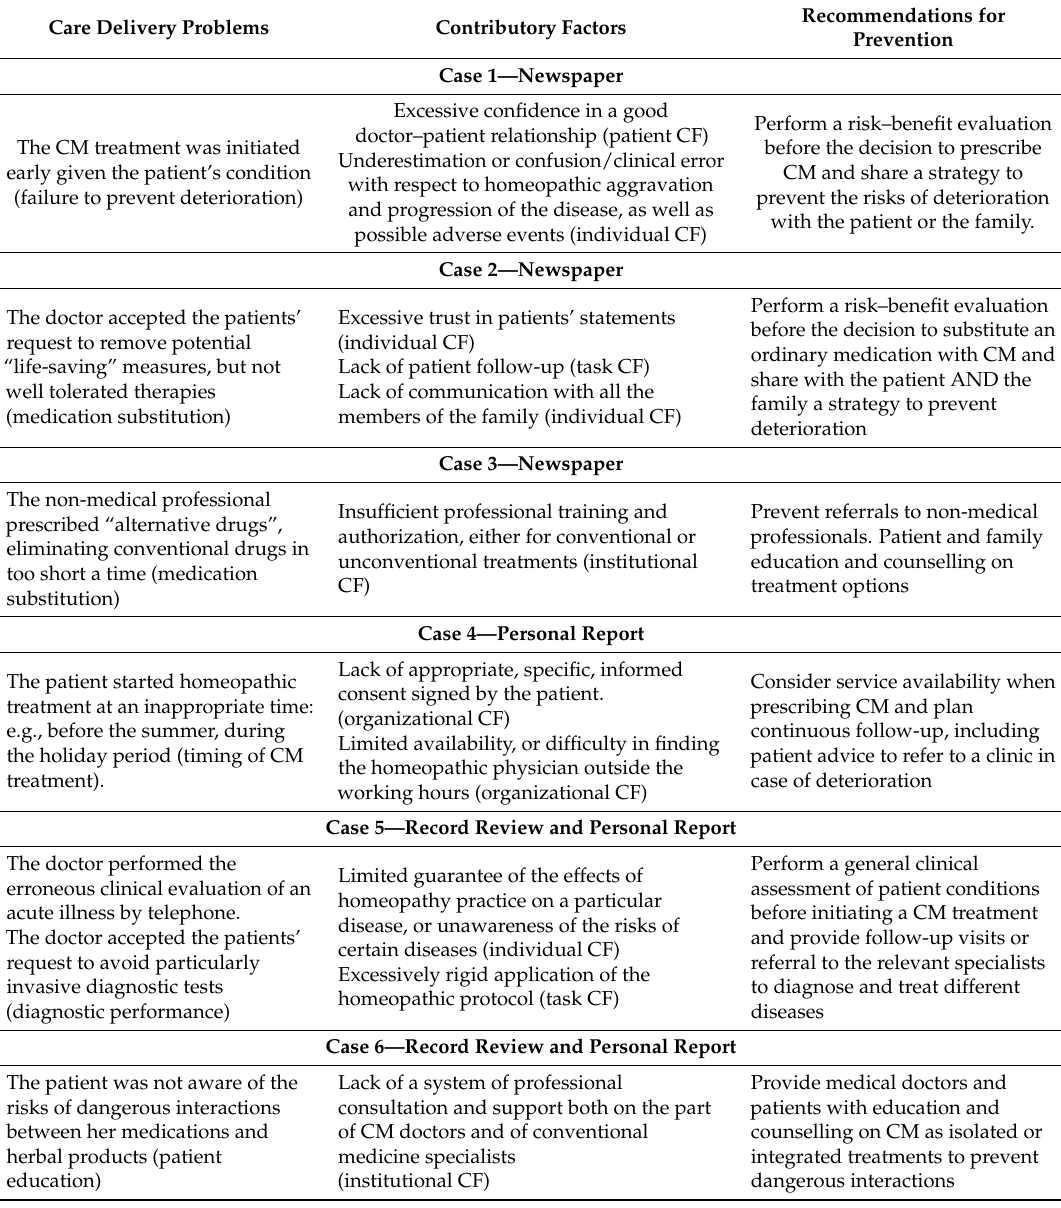
Table 4. Results of significant event audit (SEA) on six adverse events (AEs). CM: complementary medicine; CF: contributory